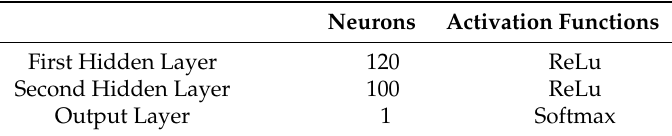
Table 2. Feed-forward NN model.